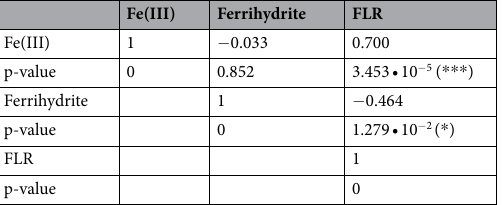
Table 2. Result of the partial correlation test. The partial correlation coefficient is reported together with the p-value of the test. AD and control groups have been pooled. The asterisk ( * ) indicates that the p-value is less than 0.05 while the triple asterisk ( *** ) indicates that p <